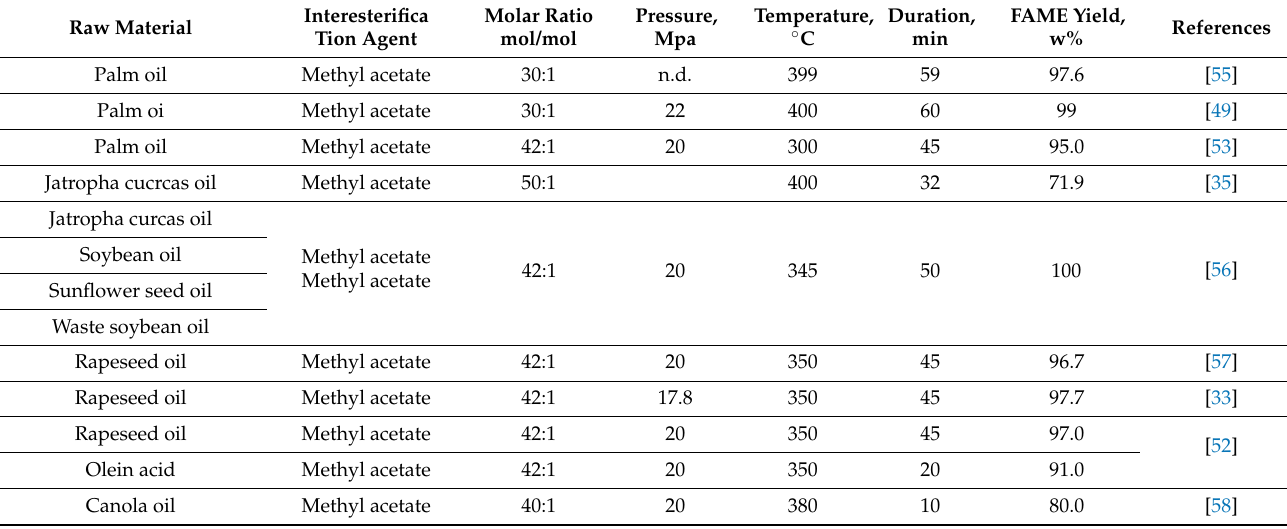
Table 3. Summary of reported experiment data of catalytic biodiesel production using supercritical carboxylate esters of low molecular